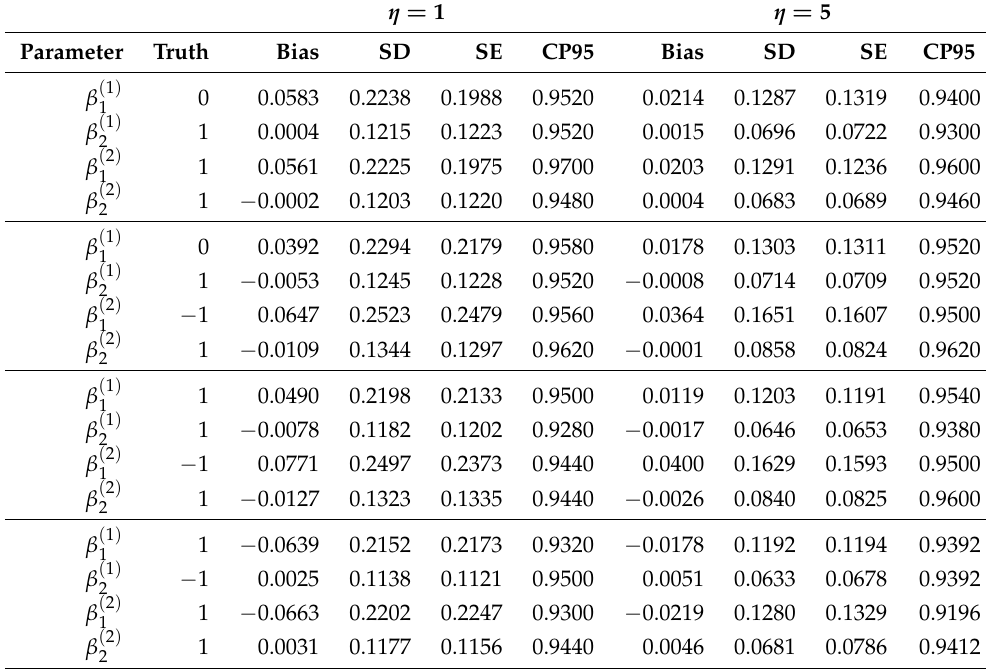
Table A1. Simulation results: estimation of regression coefficients from our proposed method when true α = 1. Bias refers to the difference between the average of the 500 posterior means and the true value; SD refers to the mean of the 500 posterior standard deviations; SE refers to the standard deviation of the 500 posterior means, and CP95 refers to the 95% coverage